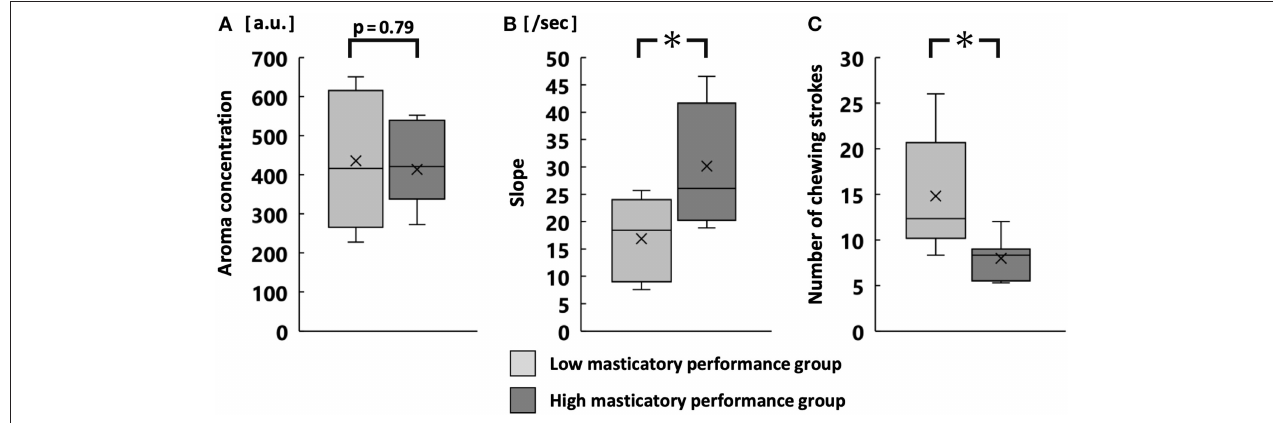
FIGURE 4 | Maximum aroma concentration (A) , slope (B) , and number of chewing strokes without aroma release (C) during free intake. * p < 0.05.